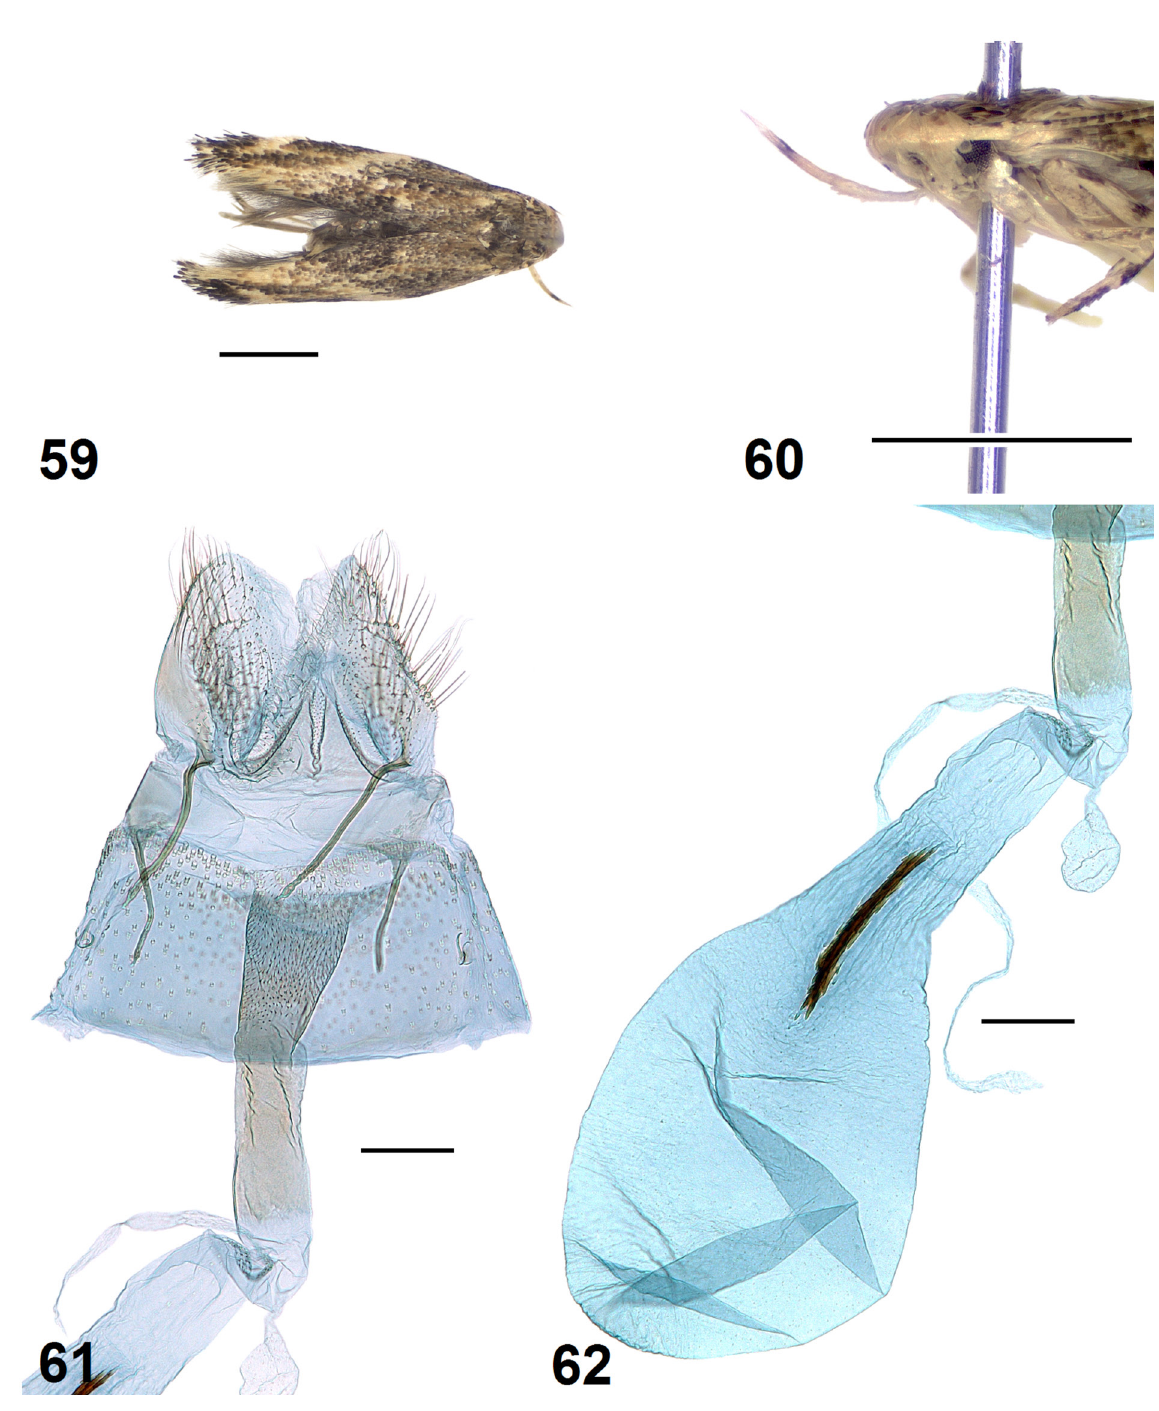
Figs 59–62. Elachista sp. (MZH VS3/29.03.19). 59 . Adult female. 60 . Head, latero-frontal view. 61 . Female genitalia, caudal part. 62 . Ductus and corpus bursae. Scale bars: 59–60 = 1 mm; 61– 62 = 0.1